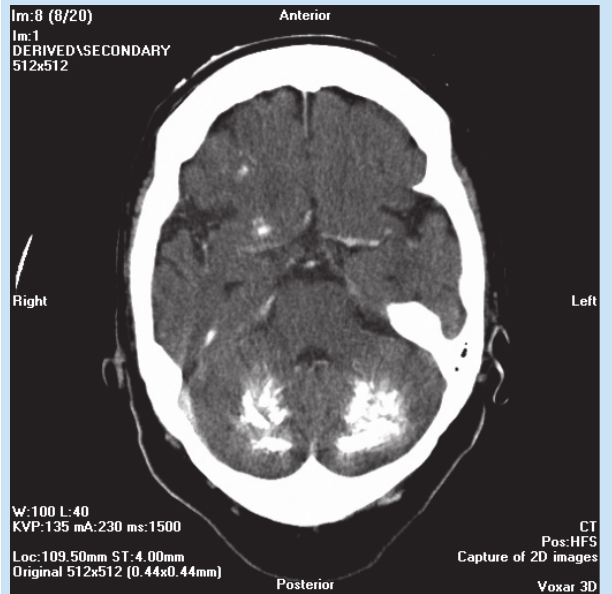
Fig. 1. Dense calcification of the dentate nuclei bilaterally.